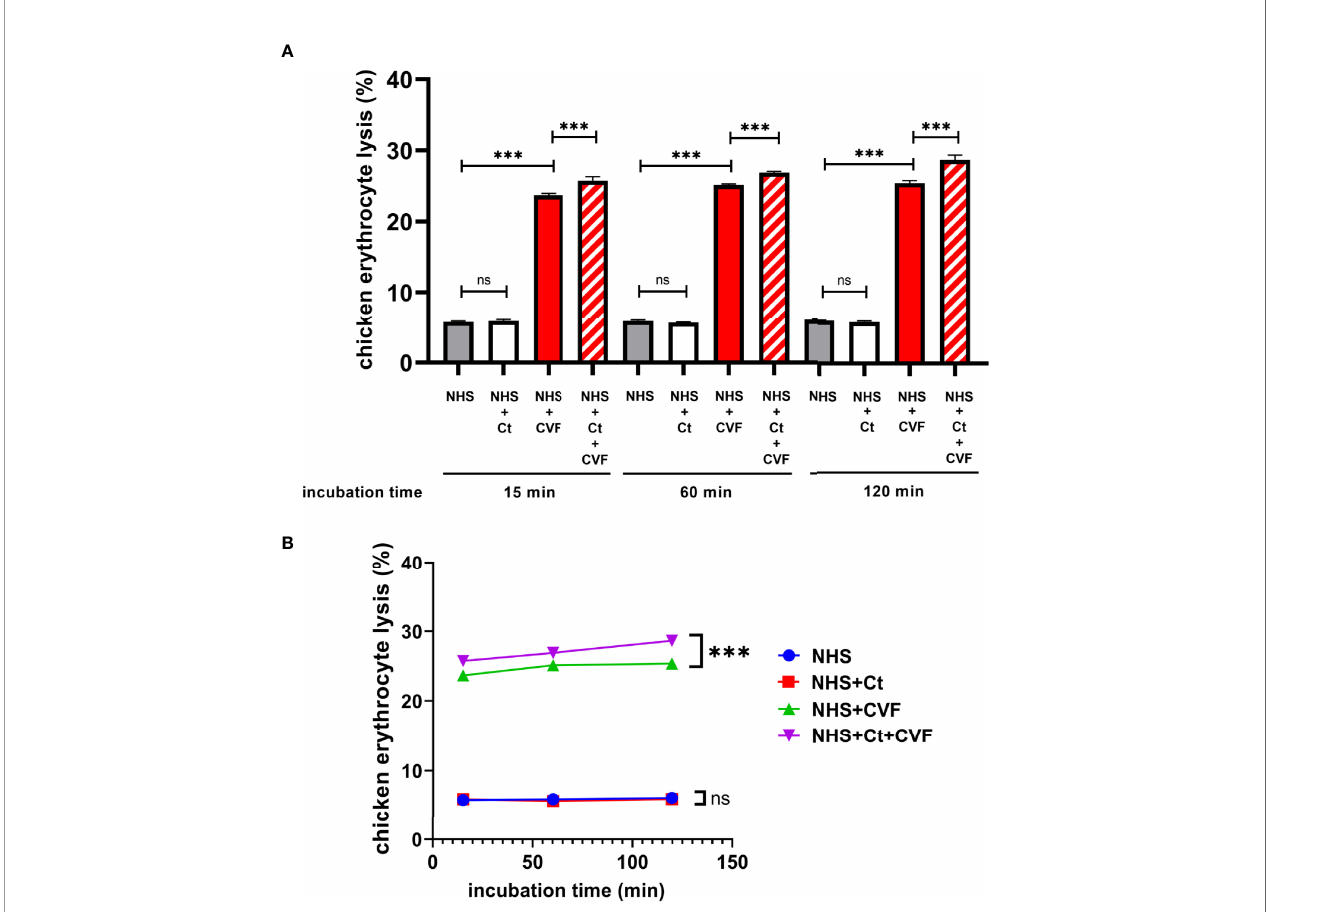
FIGURE 3 | C5b Ct -9 modi fi ed by C. trachomatis exhibits more lytic activity than C5b-9. (A) Hemolysis assays showed that incubation of both C . trachomatis - HeLa229 cell lysates and CVF with NHS signi fi cantly enhanced the lytic activity of the resulting products. (B) Line chart showing the lysis rate of erythrocytes was almost constant over the incubation time. ns, not signi fi cant; ***P < 0.001 (Dunnett ’ s multiple comparisons test, n =3). NHS, Normal human serum; Ct, C . trachomatis - HeLa229 cells lysates; CVF, Cobra venom